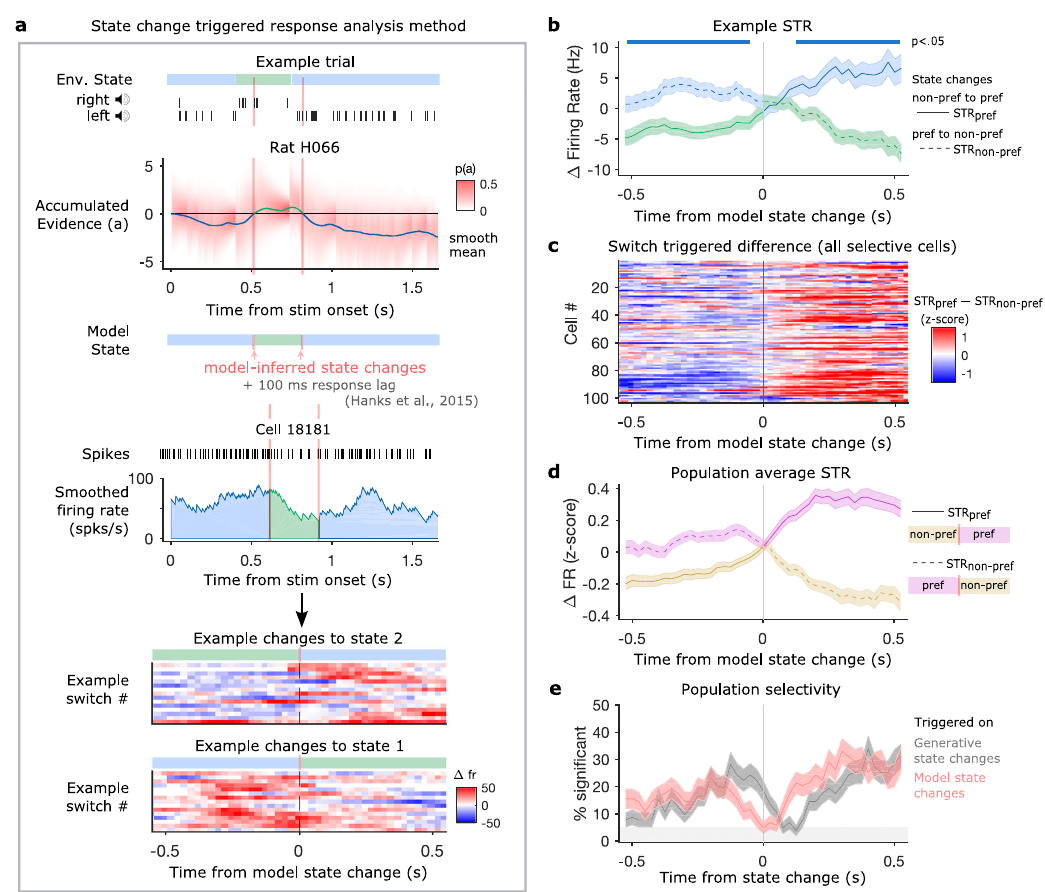
Fig. 4 FOF neurons track changes in the provisional decision. a Schematic explaining method used to compute state change triggered responses (STR). A given trial has a hidden environmental state (blue and green bar) used to generate click trains from each speaker. We compute the posterior distribution of accumulated evidence given the choice at each time point, p ( a ). We fi nd time points where the smoothed posterior mean crosses the decision boundary and label these model-inferred state changes. We then select the residual smoothed fi ring rates from the 550 ms before and after each state change and average together the residual responses for changes into state 1 and changes into state 2. b STR (mean ± s.e.m.) for the example cell used in panel A. Signi fi cance bars indicate time points when d 0 for discriminating model state is different from chance (2-tailed permutation test, 250 permutations, p < 0.05). The trace showing changes into the cell ’ s preferred state (state 2 for this cell) is labeled STR cell ’ s non-preferred state is labeled STR non-pref (dashed line). c Heat map showing difference between responses for changes into the preferred and non- preferred state (STR pref − STR non − pref ) for each of the pre-movement side-selective cells. d Average z scored STR (mean ± s.e.m.) across all pre- movement side-selective cells for state changes into cells' preferred states and non-preferred states. e Percentage of included cells (mean± s.e.m.) with signi fi cant encoding across time relative to model predicted state changes (red trace) and generative state changes (gray trace). Source data are provided as a Source Data we expect them to take intermediate fi ring rates during changes of mind and not show signi fi cant encoding of either state. If our behavioral model accurately predicts the timing of changes of mind, these intermediate fi ring rates should coincide with model state changes. As predicted, we fi nd that the population reaches its minimum fraction of cells differentiating between states at the time of the model-predicted state change. We recomputed the timecourse of discriminability across cells triggered on changes in the veridical environmental state, rather than the model- predicted changes. When we do this, we fi nd the time point at which the minimum fraction of cells signi fi cantly discriminates between states is delayed relative to generative state changes. This is consistent with the FOF tracking changes in the sign of accumulated evidence rather than simply responding to the instantaneous stimulus. At the level of individual cells and across the population, we see rapid responses to changes of mind, providing further evidence that neurons track the animal ’ s provisional decision throughout the accumulation process.